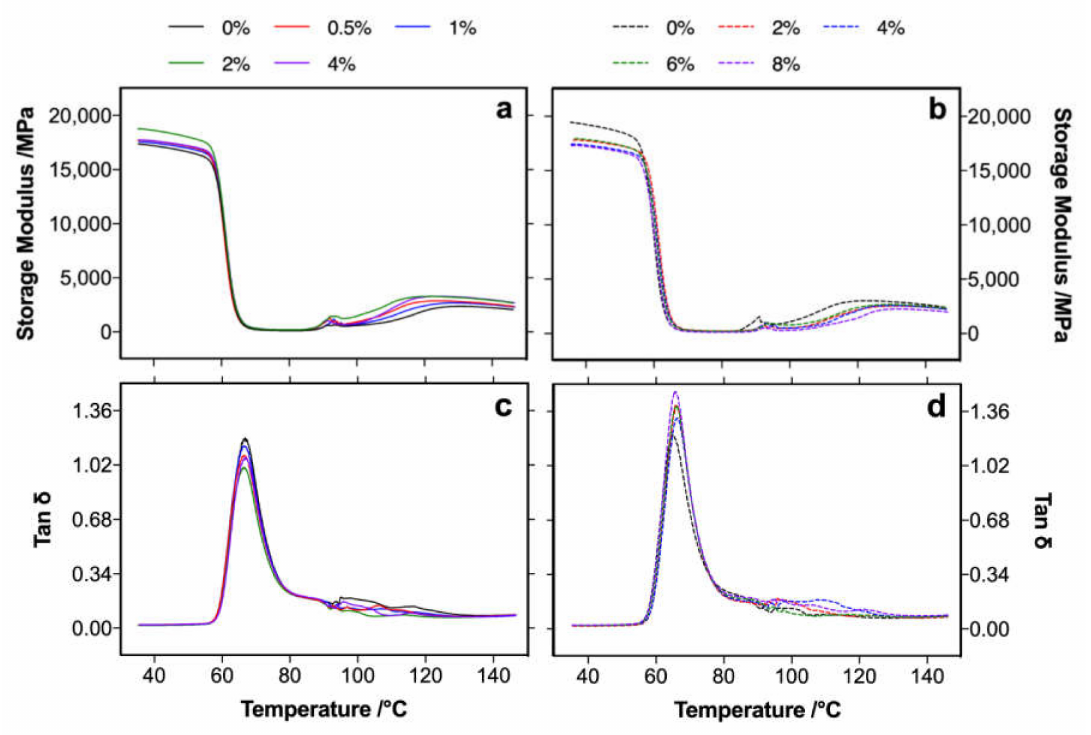
Figure 5. Storage modulus ( a , b ) and loss factor ( c , d ) of the MA- ( a , c ) and KH550- ( b , d ) modified poplar fiber / PLA